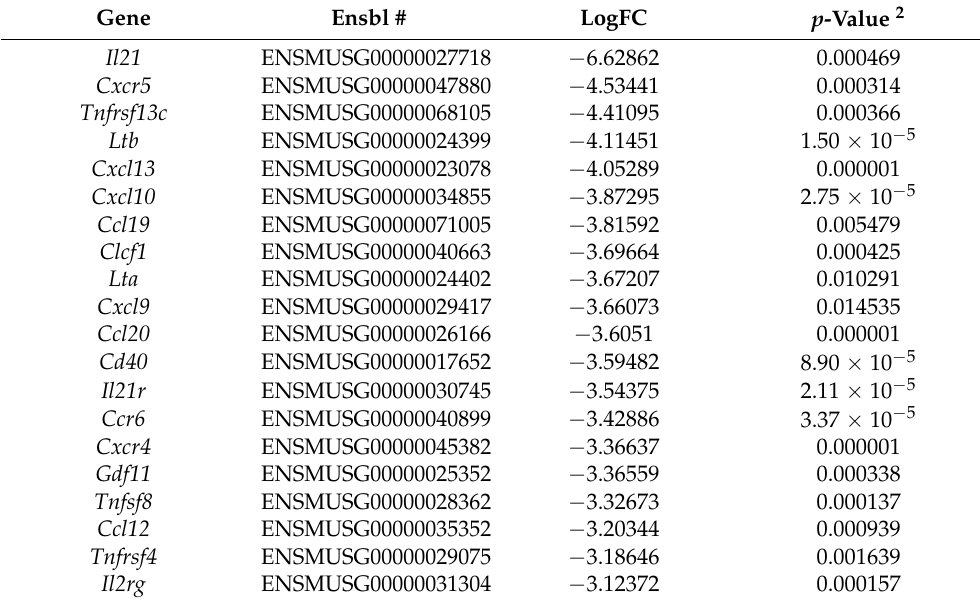
Table 4. Top 20 DE genes in cytokine-cytokine receptor interaction pathway 1 . Gene Ensbl #